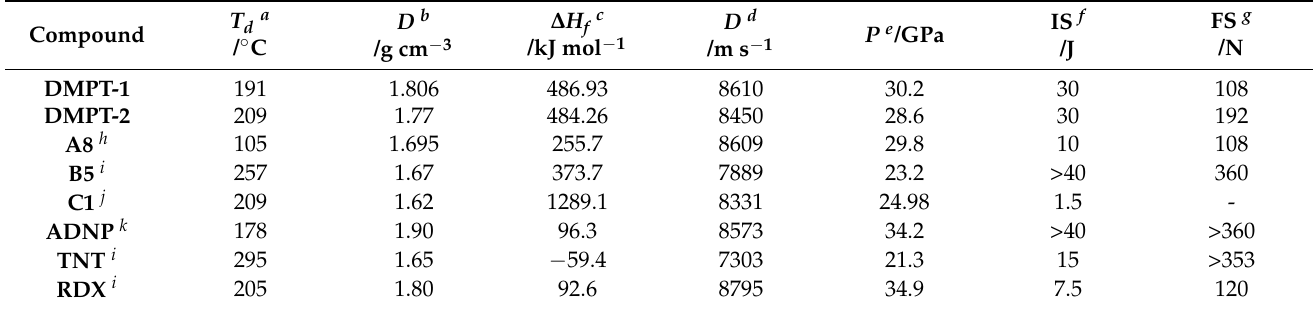
Table 1. Physicochemical properties of DMPT.